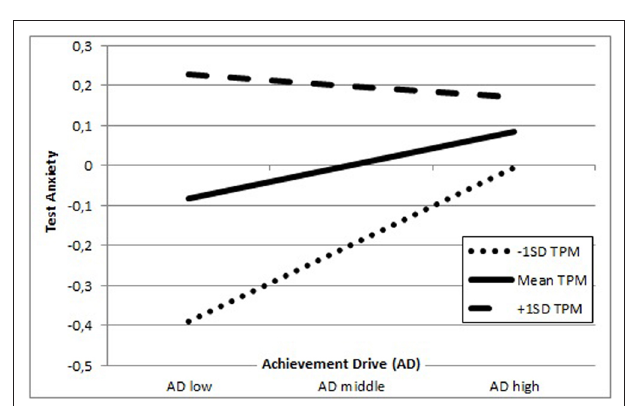
FIGURE 6 | Representation of teachers as positive motivators (TPM) as moderator in the association between achievement drive (AD) and test anxiety (TX) among Canadian secondary school students; the Y-axis shows test anxiety and the X-axis shows achievement drive.